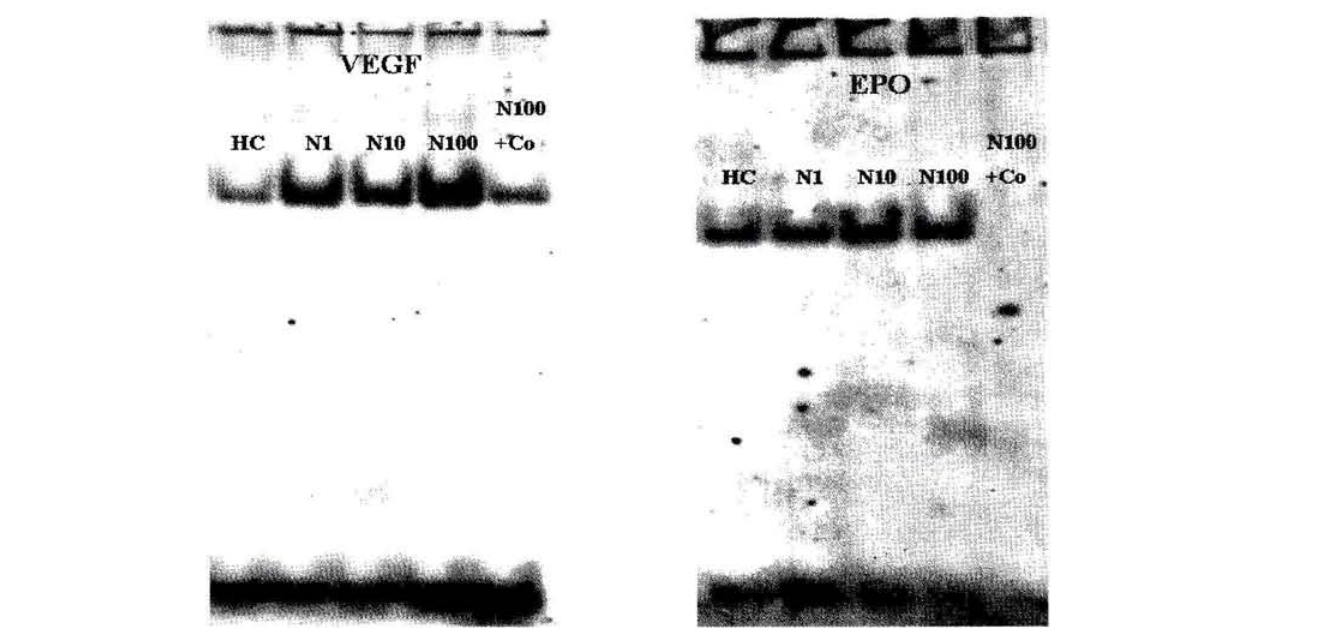
Figure 4. Activation of hypoxia inducible factor-1 (HIF-1 ) under hypoxic conditions detected by electrophorctic mobility shift assay in nuclear extracts of OVCAR-3 cells following 1 h-incubations with neopterin at concen- trations of 1 μΜ (Ν 1 ), 10 μΜ (ΝΙΟ), and 100 μΜ (NI00). Nuclear extracts were incubatcd with digoxigenin-11- ddUTP-labeled oligonucleotide probes representing HIF-1 consensus binding sequences either within the pro- moter of the human vascular endothelial growth factor (VEGF) gene or within the enhancer segment of the human erythropoietin (FPO) gene. NC indicates normoxie controls, Co indicates an unlabeled oligonucleotide control probe. Results are representative of three different